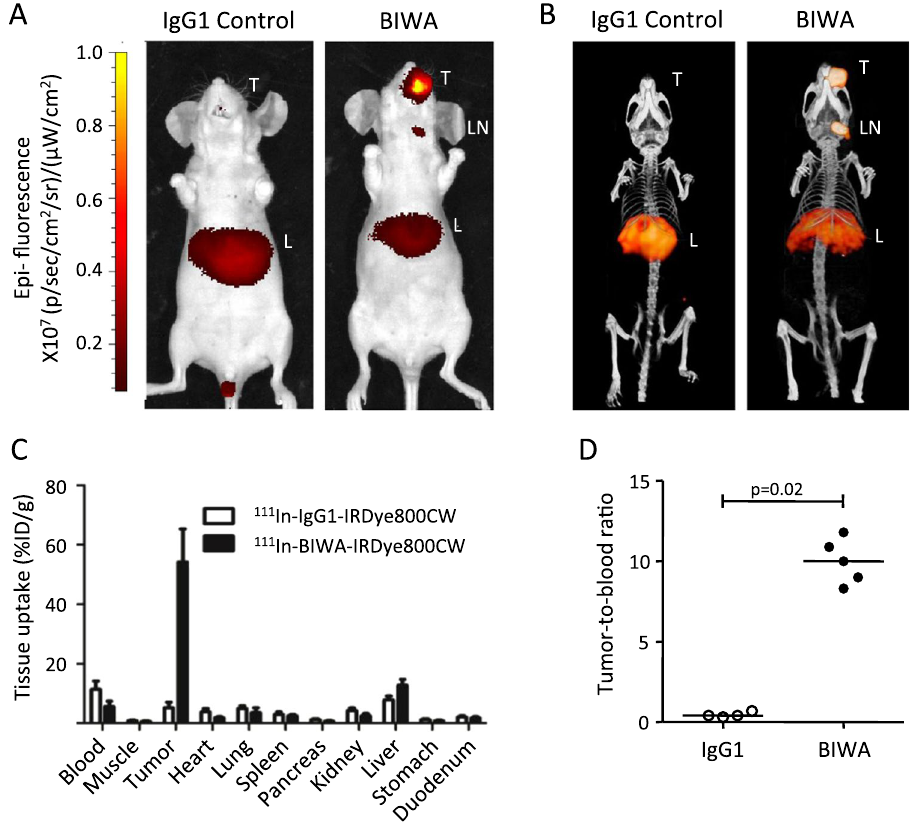
Figure 3. Biodistribution of 111 In-DTPA-BIWA-IRDye800CW and 111 In-DTPA-IgG1-IRDye800CW control antibody in mice carrying HNSCC tumors in the left cheek for 28 days and 72 h after i.v. administration. ( A , B ) Near infrared fluorescent (NIRF) whole body images of mice n = 9 (A) and corresponding micro SPECT/CT images n = 4 (B). Tumor (T), lymph node (LN), liver (L). ( C ) Biodistribution data shown as percentage injected dose per gram of tissue of both dual-labeled antibodies. ( D ) Tumor-to-blood ratios obtained by ratios from